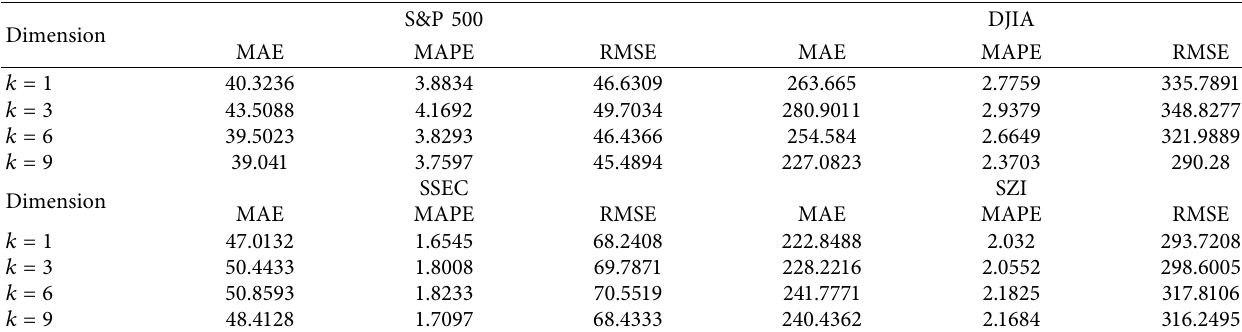
Table 5: Forecasting errors of the FM-Elman model when θ � 0.